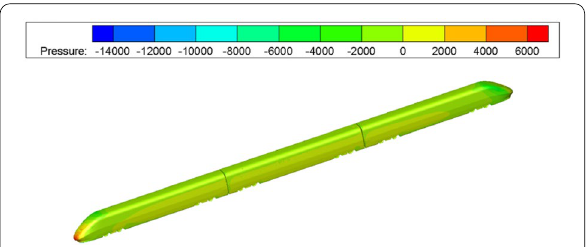
Figure 10 Pressure distribution of the train